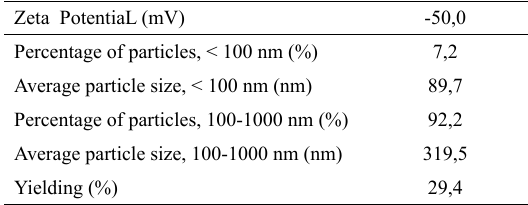
Table 2: Zeta potential, particle size and yielding of nanocrystals of cotton